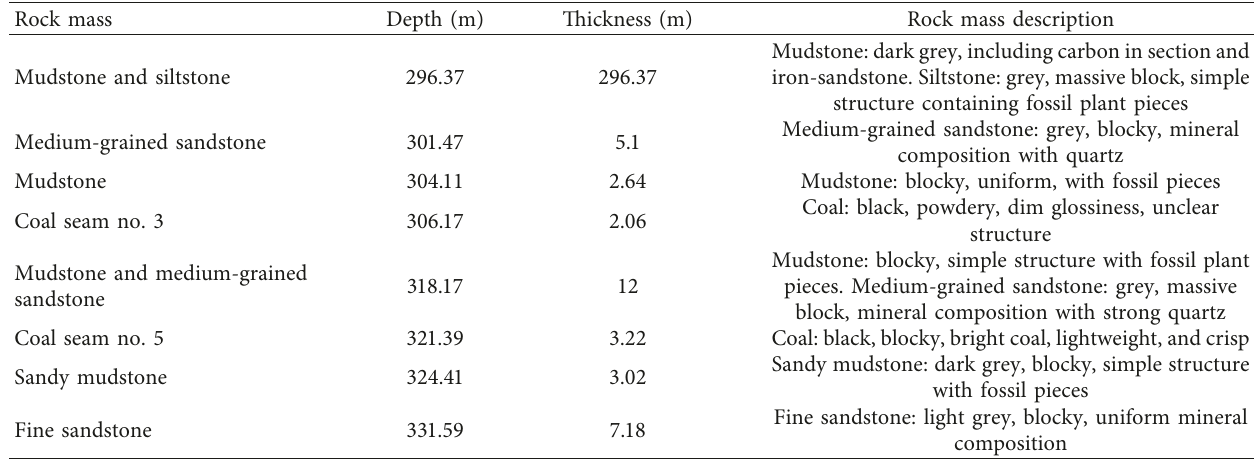
Figure 2: Schematic view of the panel arrangements and survey lines for subsidence measurements in (a) Case 1 and (b) Cases 2 and 3. Table 1: Lithology of Case 1.